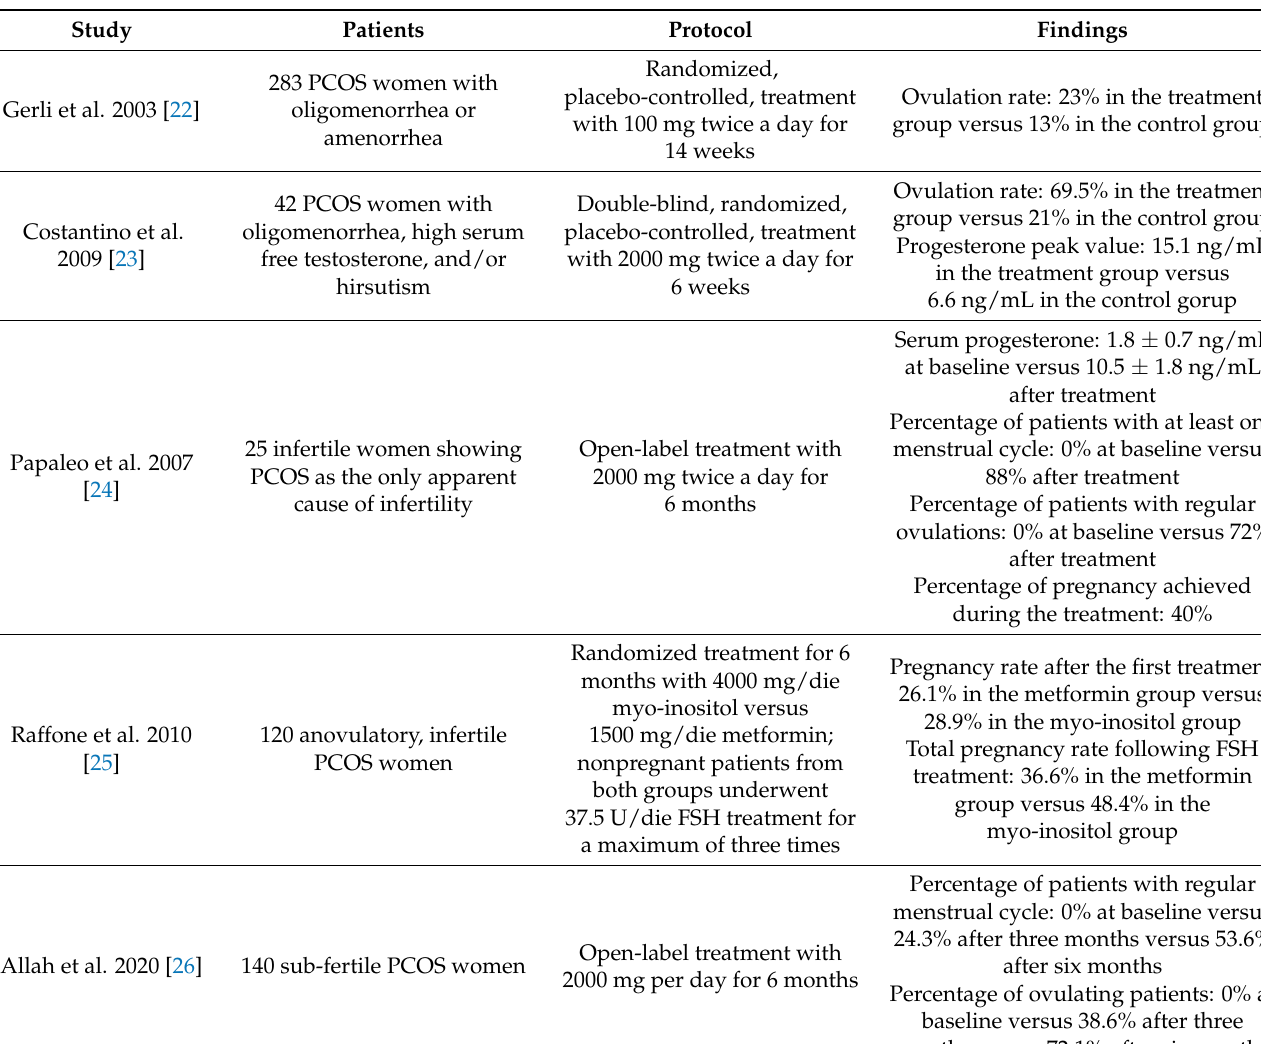
Table 1. Summary of the studies involving myo-inositol as a treatment for ovulation induction, regularization of menstrual cycle or in the pursuit of